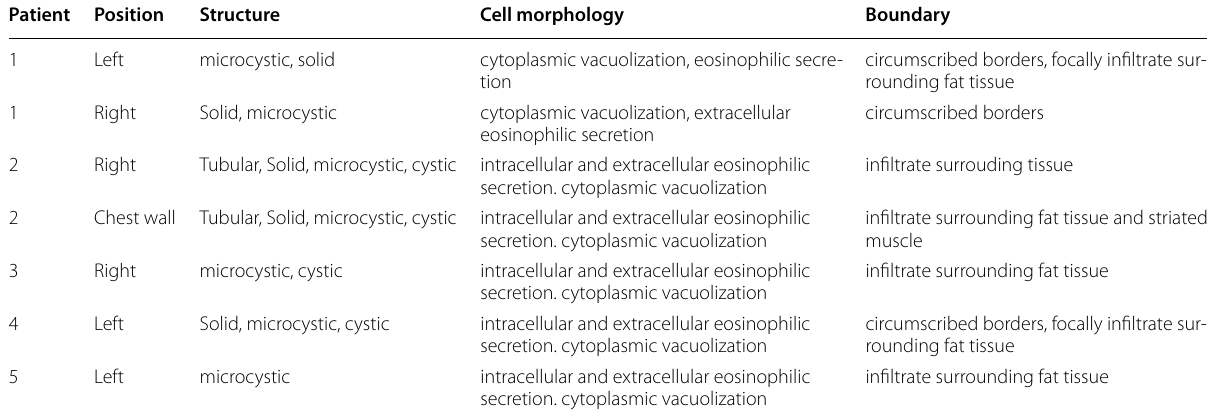
Table 2 The histological features of SBCs Patient